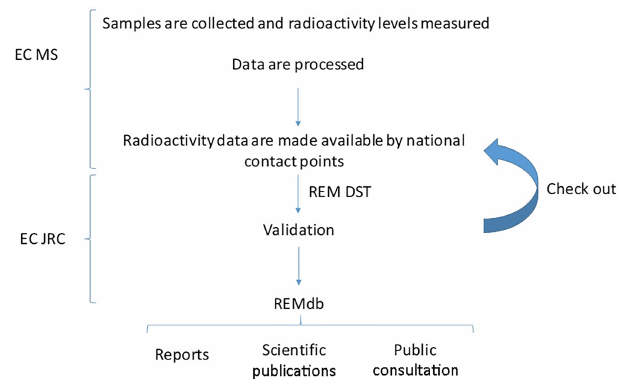
Figure 1. Flow of data to be stored in